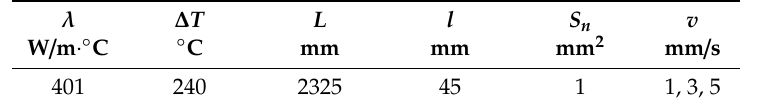
Table 3. Data of parameters in Equation (1).